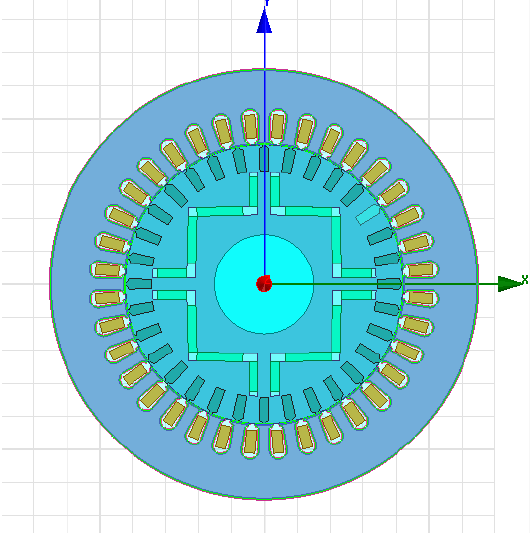
Figure 2. 2D finite element model of motor.